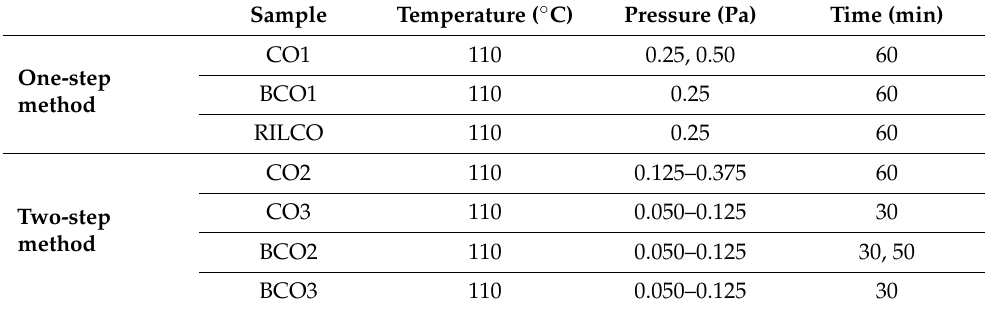
Table 2. Processing parameters for different laminate samples produced by one-step and two-step methods.